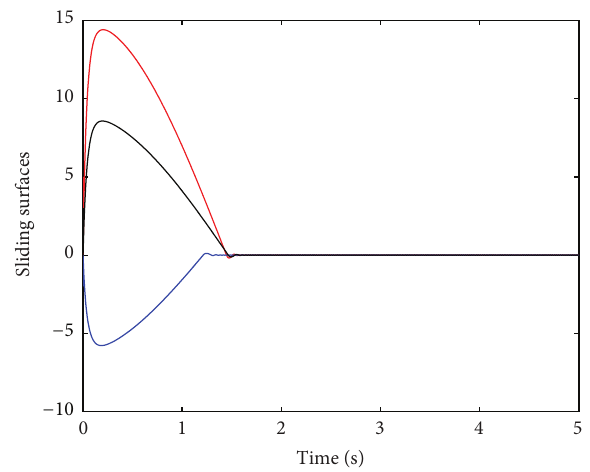
Figure 14: Sliding surfaces states in the presence of systematic uncertainties and external disturbances with 𝛼 = 1 (red line represents the first sliding surface state 𝑠 1 , blue line represents the second sliding surface state 𝑠 2 , and black line represents the third sliding surface state 𝑠 3